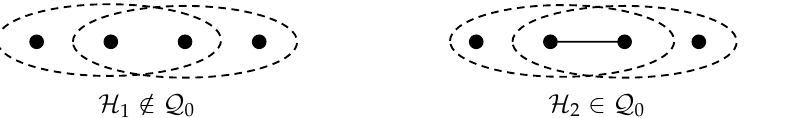
Figure 1. Mixed hypergraphs H 1 and H 2 , where dotted closed curves represent C -edges and solid line represents D